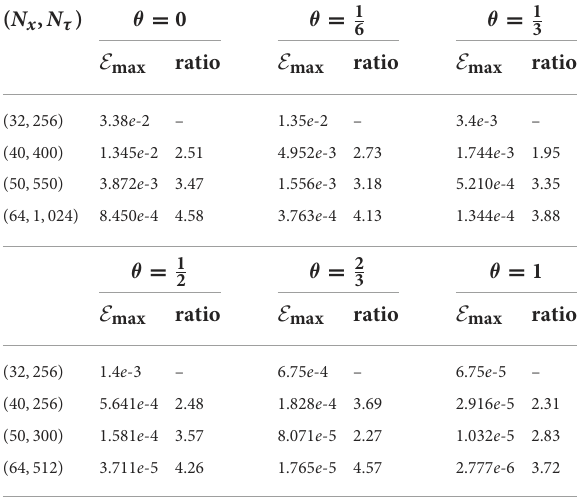
TABLE 2 The absolute maximum errors for various grids ( N x , N τ ) and their convergence rates for all cases of θ -parameter of Example 1.